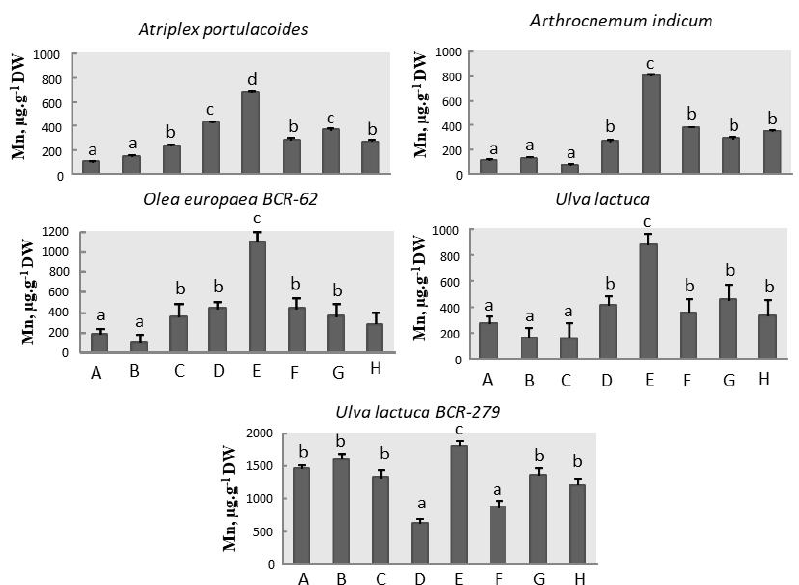
Figure 2. Contents of Mn ( µ g · g − 1 DW) in atriplex portulacoides, arthrocnemum indicum, olea europea BCR-62, ulva lactuca and ulva lactuca BCR-279 using methods A, B, C, D, E, F, G and H. Values were presented as mean ± standard deviation, n = 10. Letters (a, b, c, d) show a significant difference ( p < 0.05) between the concentrations attained by different extraction procedures.